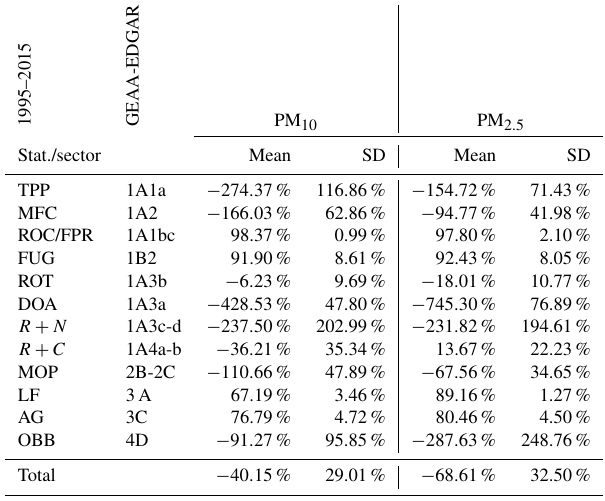
Table A10. Comparison of total annual values for GEAA and EDGAR from 1995 through 2015 for